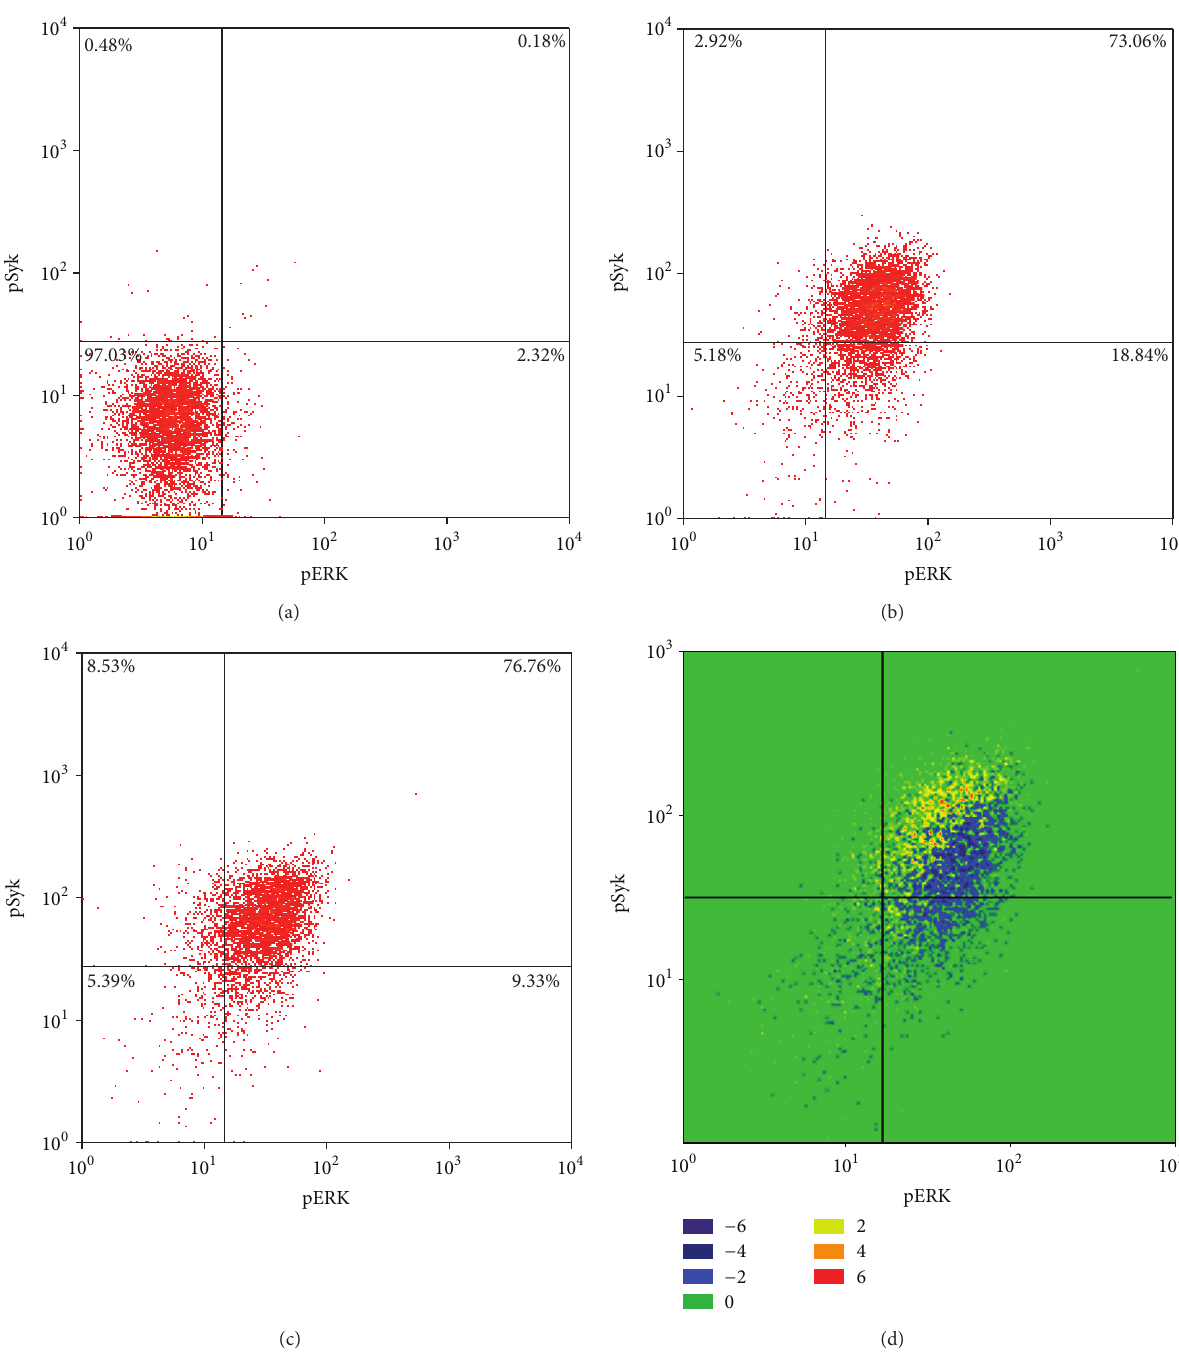
Figure 5: Two-dimensional histogram representation of pSyk versus pERK after stimulation of BCR with anti-mu (12.5 𝜇 g/mL). (a) Control cells at 0 minutes after stimulation of the BCR; (b) 5 minutes after stimulation of the BCR; (c) five minutes after BCR stimulation in Hg +2 intoxicated cells; (d) “Overton” subtraction of (c) from